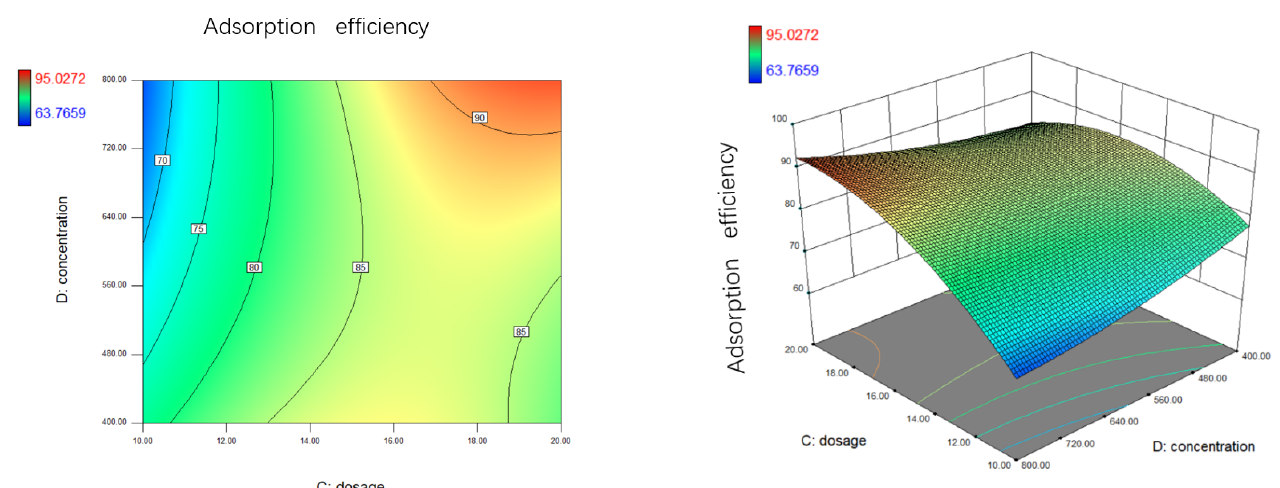
Figure 18. The 3D response surface and 2D contour line map plots for carmine decontamination.